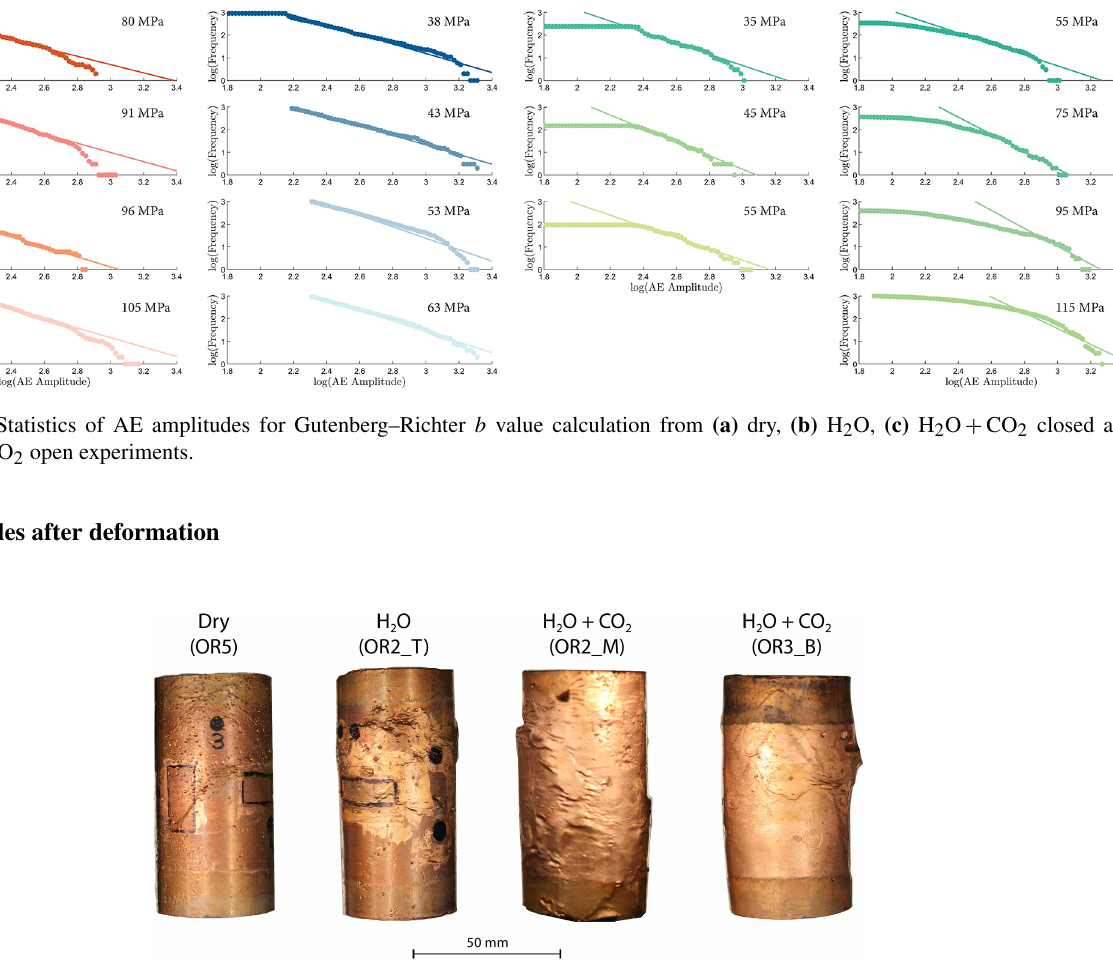
Figure A8. Photo of samples after deformation. The dry sample did not reach the final dynamic failure before the experiment was